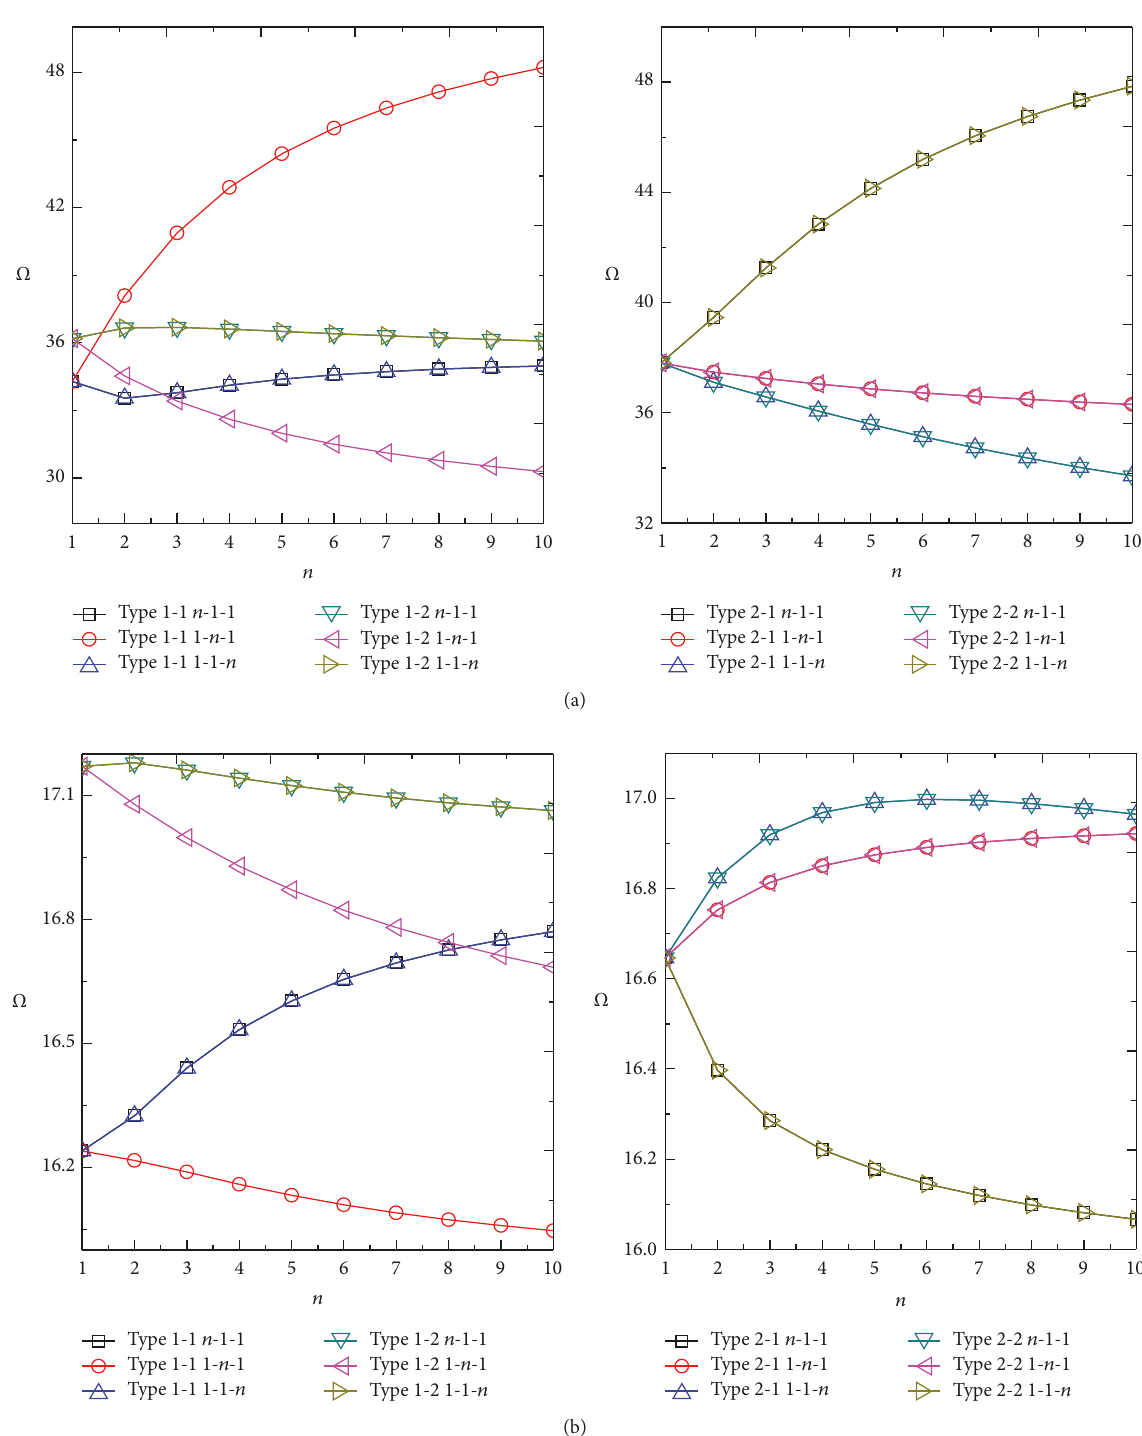
Figure 14: Variations of fundamental frequency parameter Ω of circular sector plate with material types and different thickness schemes ( 𝜙 = 120 ∘ , ℎ/𝑅 1 = 0.2, and 𝑝 1 = 𝑝 3 = 5): (a) CCC; (b) E 3 E 3 E 3